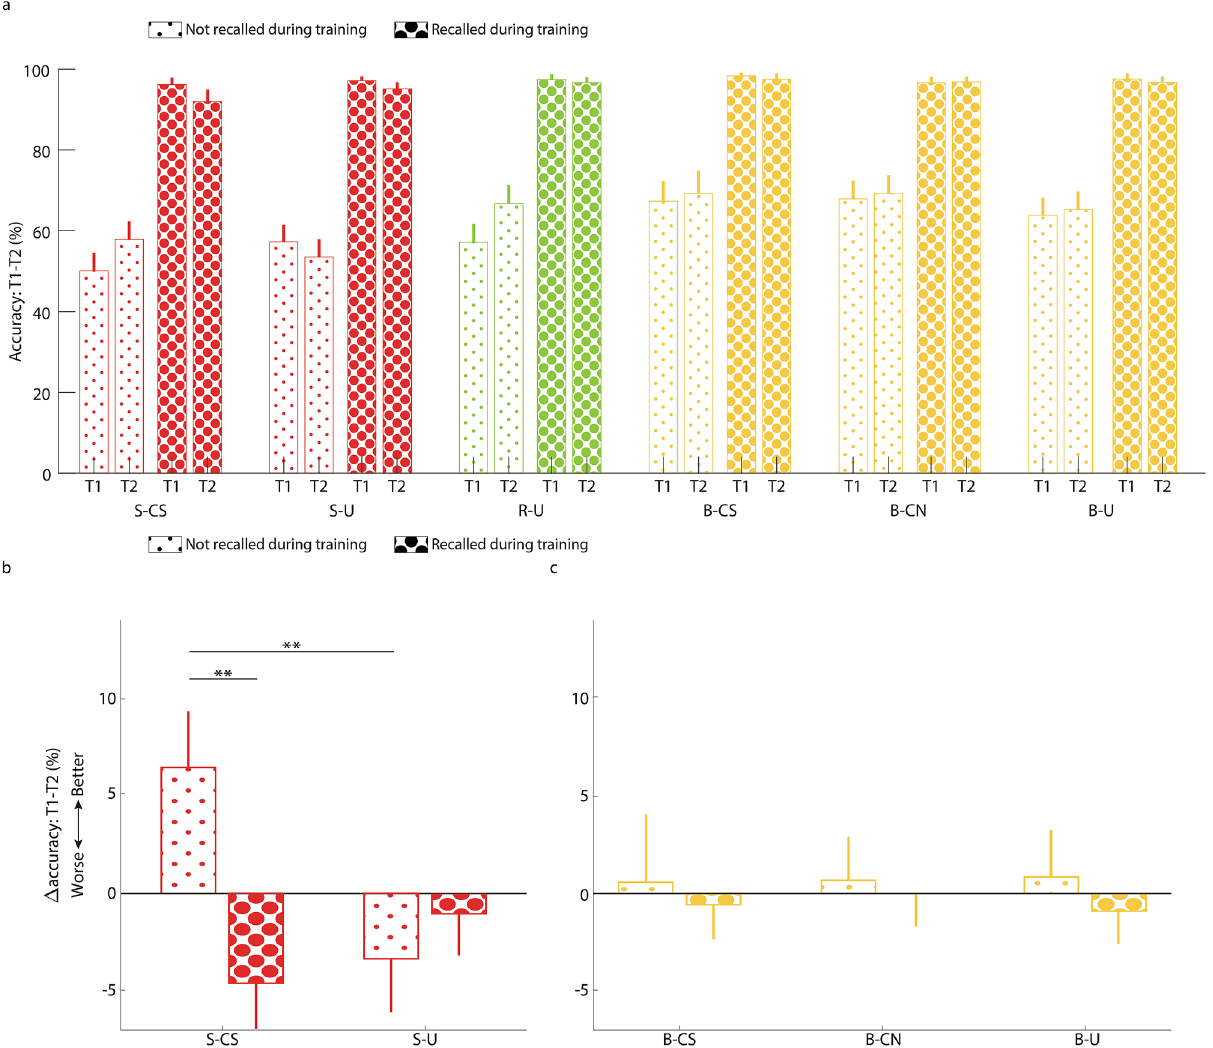
Figure 4. The benefit of reactivation for weakly encoded memories, as revealed by considering recall during training. ( a ) Recall accuracy in T1 and T2 as a function of condition and whether recall occurred during training (large dots) or did not occur during training (small dots). Error bars denote standard error of the mean between participants. ( b ) Changes in recall accuracy compared for the two suppression conditions, showing a memory improvement preferentially for the words that were not recalled during training. ( c ) A parallel analysis conducted for the three baseline conditions. Values in panels ( b ) and ( c ) reflect coefficient estimates produced by the linear model; error bars in panels ( b ) and ( c ) denote standard error of the mean for coefficients. ** p < 0.01. S-CS suppression–cued suppression, S-U suppression–uncued, R-U response–uncued, B-CS baseline– cued suppression, B-NS baseline–cued novel, B-U